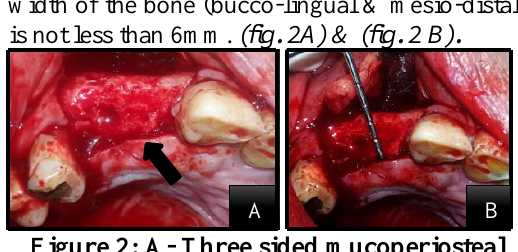
Figure 2: A- Three sided mucoperiosteal flap with palatal bias (black arrow). B- Ridge width measurement by periodontal